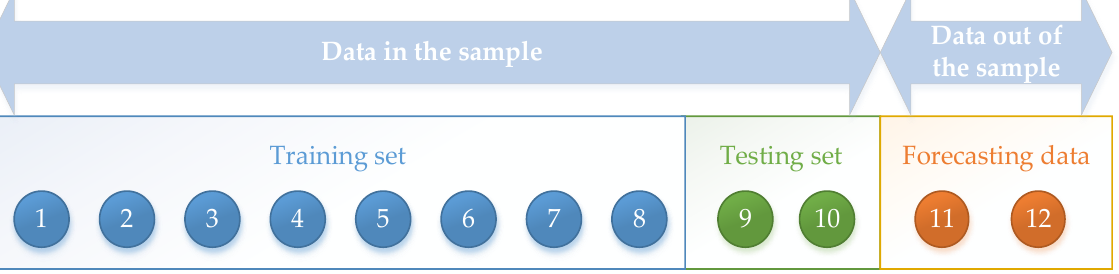
Table 3. Comparison of fitting and predicted birth rate in China from 2011 to 2020.